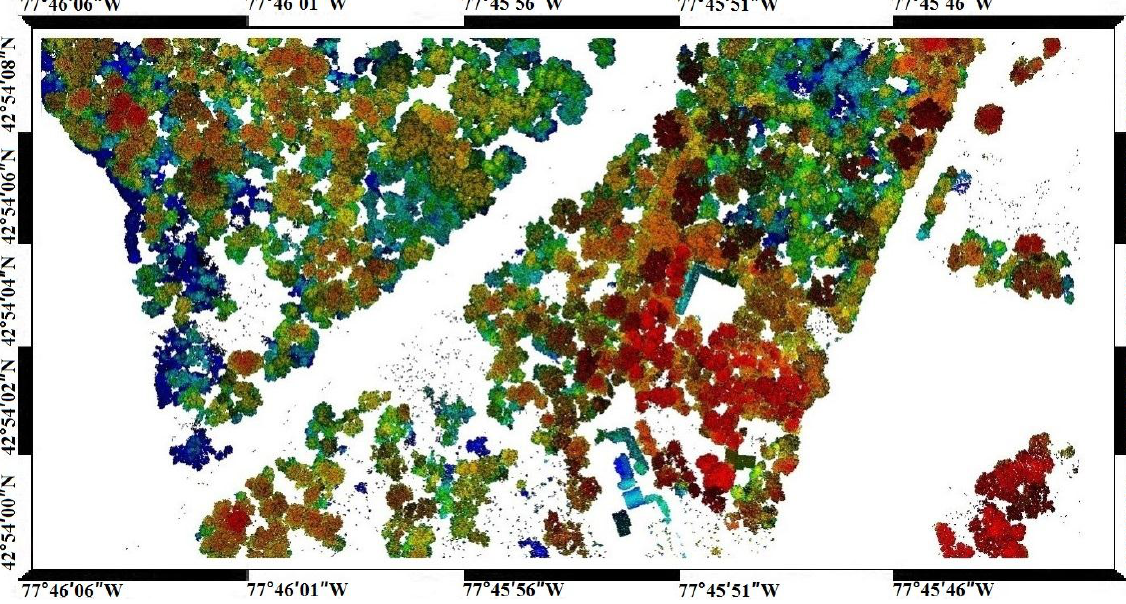
Figure 10. 3D fractal dimension distribution in the study area.